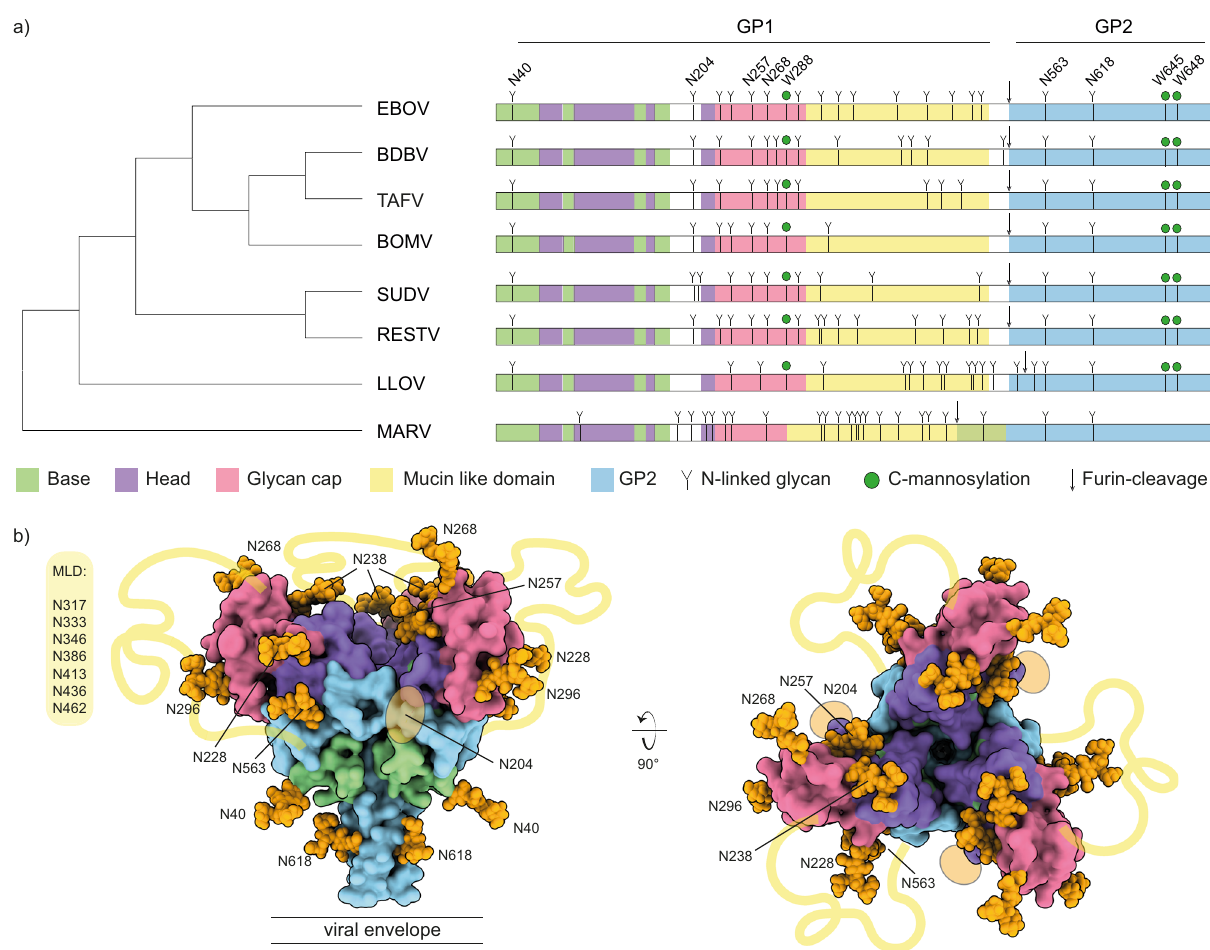
Fig. 1 Sequence and structure analysis of Filovirus GP glycosylation. a Schematic of fi lovirus GP domain structure with annotated N-linked glycosylation and C-mannosylation. The cladogram on the left is based on the full GP sequences. Domain coloring as indicated below the diagram. Conserved N-linked glycans in ebolavirus species are annotated on top. b Pseudomodel of EBOV GP with core pentasaccharide of N-linked glycans shown as orange spheres. Model is built with GLYCAM based on PDB ID 5JQ3. The yellow lines indicate the approximate location of the MLD, connecting the respective termini of the glycan cap and GP2